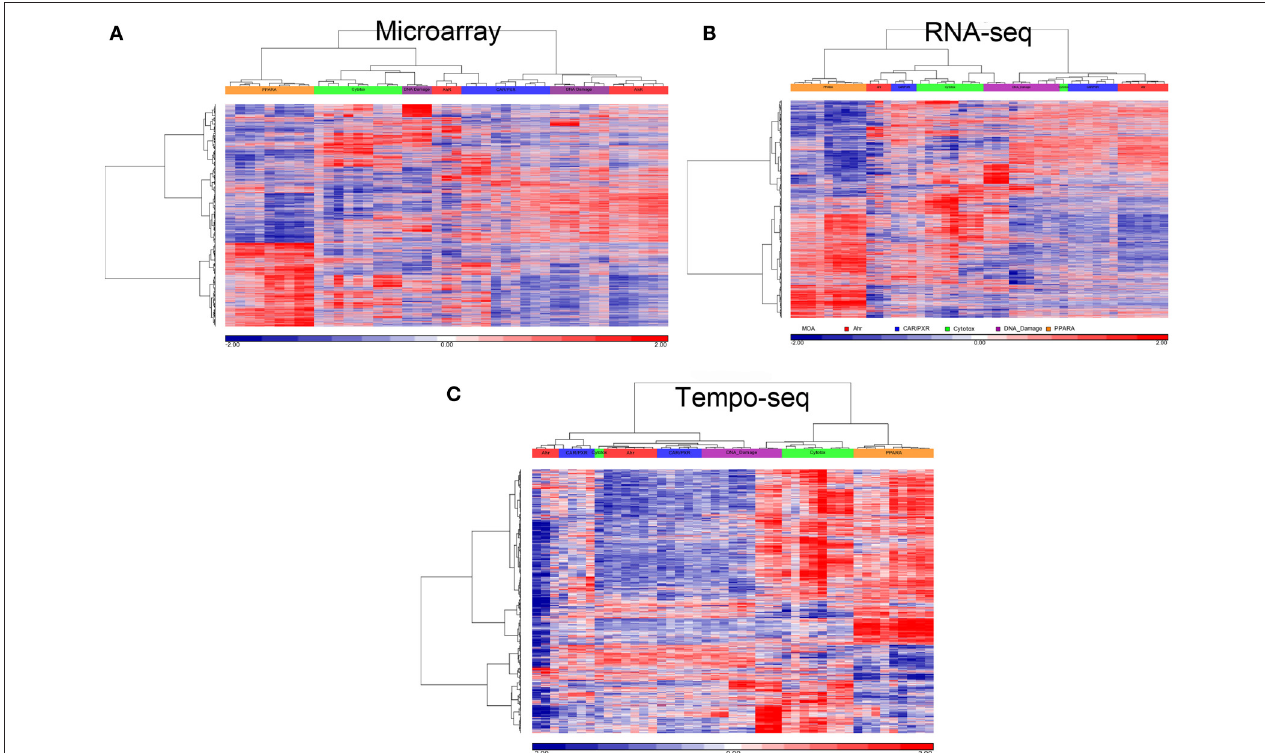
FIGURE 5 | Clustering of data. (A) Microarray. (B) RNA-Seq. (C) TempO-Seq. Clustering performed using the log 2 ratio expression data (treated to matched control according to nutritional status) of the genes that vary by MOA at FDR < 0.01 with cosine correlation as the similarity metric and the Ward clustering criterion. The data for clustering was standardized to a mean of 0 and standard deviation of 1. Samples’ MOA colored as in the legend to Figure 4A